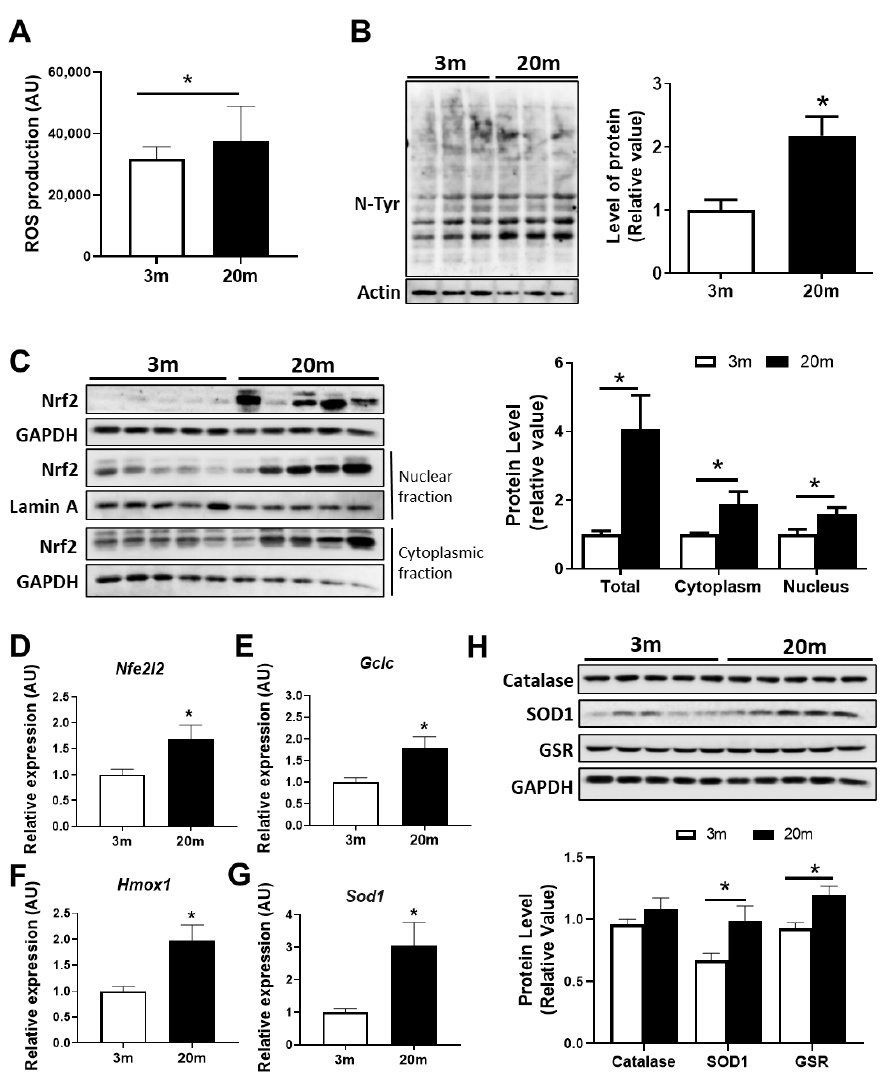
Figure 2. Oxidative stress and antioxidant responses in the aged hippocampus of female C57BL/6J mice. ( A ) ROS production of an isolated mitochondrial-enriched fraction measured by CM- H2DCFDA. ( B ) Western blot for nitrotyrosine (N-Tyr) in hippocampal lysate with their densitometric analysis expressed relative to the control. ( C ) Western blot of nuclear factor erythroid 2-related factor 2 (Nrf2) in total lysate, cytoplasmic, and a nuclear fraction of the hippocampal tissue of 3 mo and 20 mo mice with their densitometric analysis. ( D ) Relative mRNA expression of Nfe2l2 and ( E – G ) its downstream target genes, Gclc , Hmox1 , and Sod1 . ( H ) Western blot for oxidative stress defense in hippocampal with their densitometric analysis. The proteins analyzed were Catalase, Superoxide dismutase 1 (SOD1), and Glutathione Reductase (GSR) * p < 0.005, data are presented as the means ± SEM. n = 5 different animals per group.